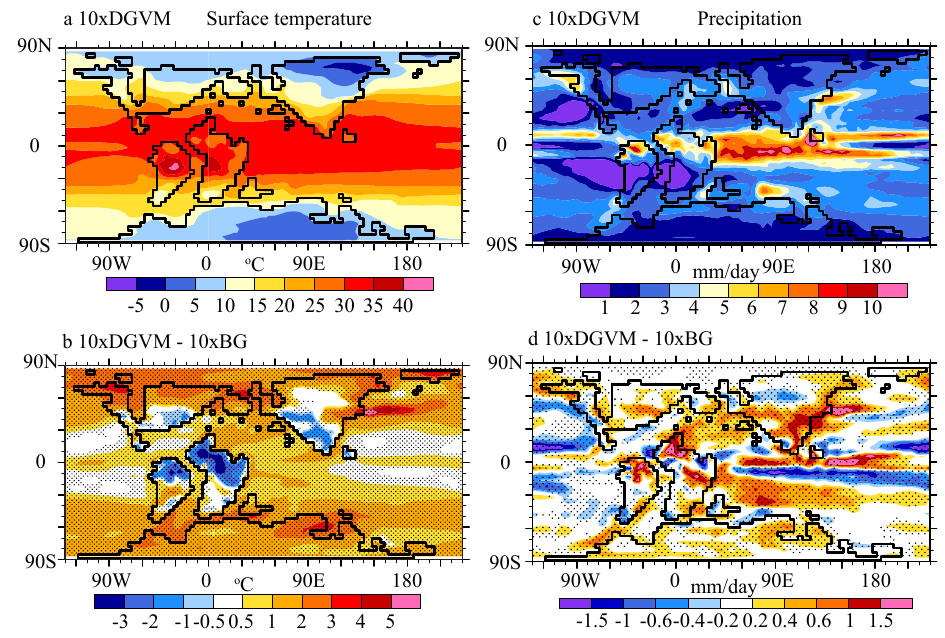
Fig. 4. Mean annual surface temperature ( ◦ C) and precipitation (mm day − 1 ) for ( a , c ) 10xDGVM experiment; and ( b , d ) 10xDGVM–10xBG experiments. In (b, d) , the differences exceed 95% confidence level are